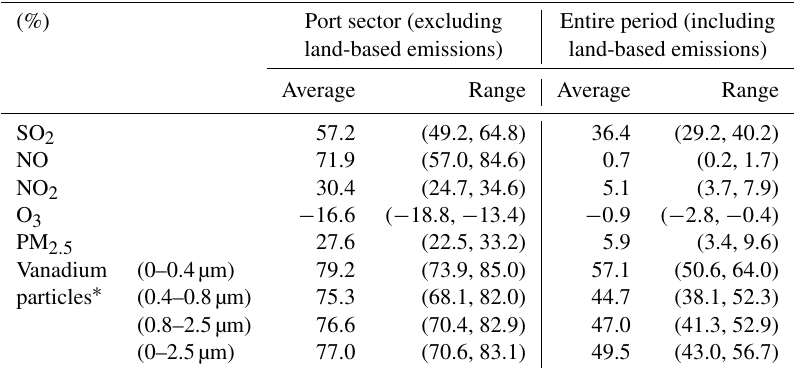
Table 2. Contributions of ship emissions to ambient pollutants SO 2 , NO, NO 2 , O 3 , PM 2 . 5 and vanadium particles in the port area. Calcu- lations are based on two situations: the entire sampling period (all wind directions included) and periods when the site is downwind of port emissions. The total lengths (in hours) of respective periods are given in the footnote.